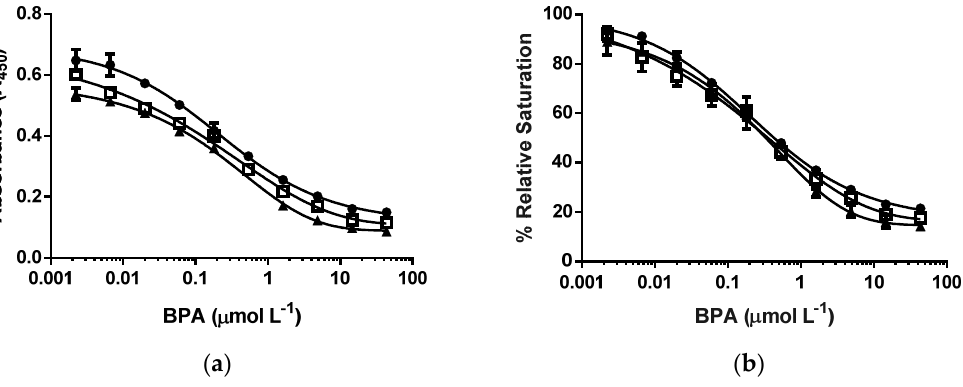
Figure 3. d-ELISA under the different molar concentrations of cysBPAv-AuNP-265. ( a ) Absorbance curve, and ( b ) % relative saturation. = the molar concentration of cysBPAv-AuNP-265 was 6.6 × 10 -10 mol·L − 1 (the concentration of epitope in an assay: 1.7 × 10 − 7 mol·L − 1 ); = the molar concentration of cysBPAv-AuNP-265 was 3.3 × 10 − 10 mol·L − 1 (the concentration of epitope in an assay: 9.0 × 10 − 8 mol·L − 1 ); = the molar concentration of cysBPAv-AuNP-265 was 1.3 × 10 − 10 mol·L − 1 (the concentration of epitope in an assay: 3.0 × 10 − 8 mol·L − 1 ).